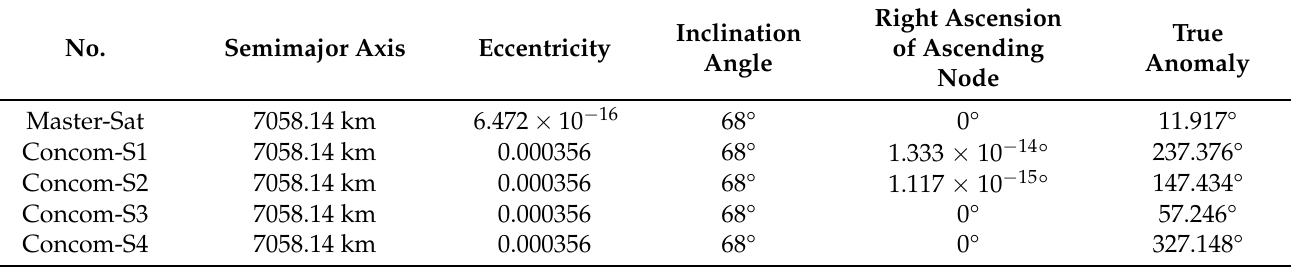
Table 1. Orbital parameters of distributed satellite